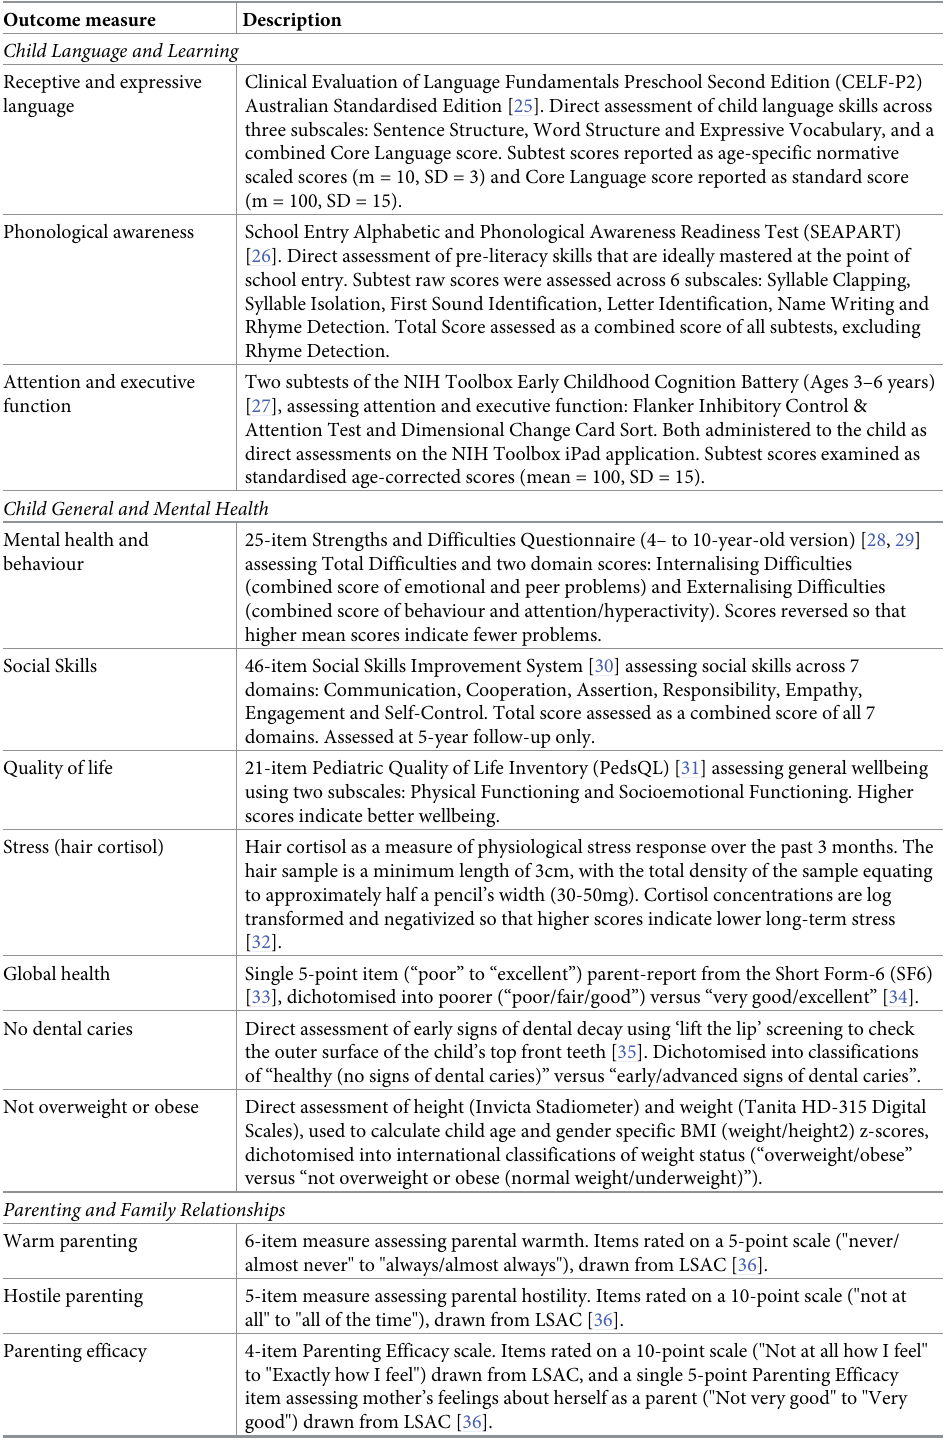
Table 1. Description of outcome measures assessed at 4 and 5